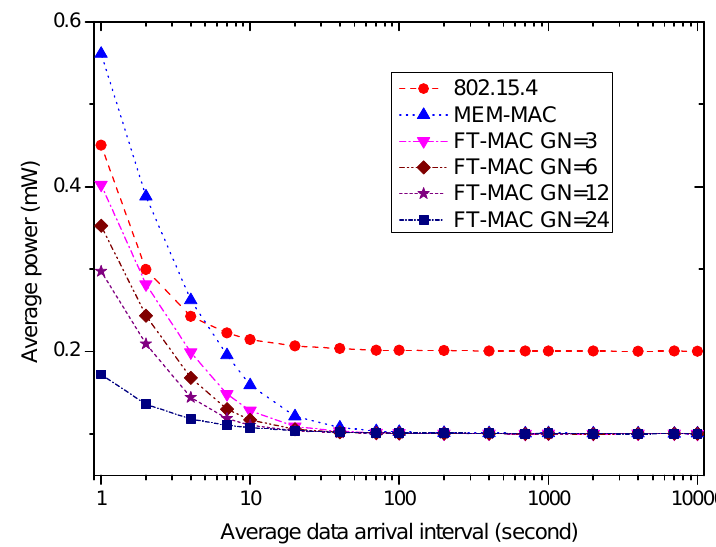
Figure 21. The effect of the average data arrival interval on the node average power.